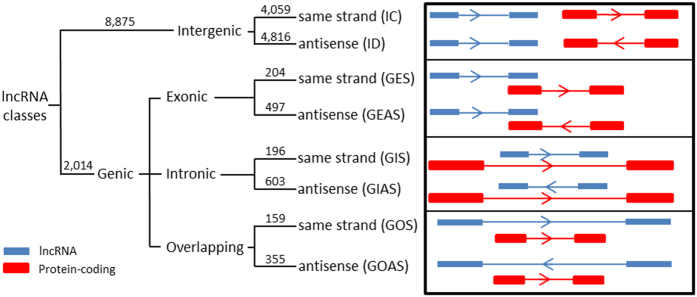
Classification of rat lncRNAs.Annotated rat lncRNAs were classified based on their genomic locations relative to protein-coding genes (see method section for more details). Number of lncRNAs in each class and subclass is indicated in parenthesis.